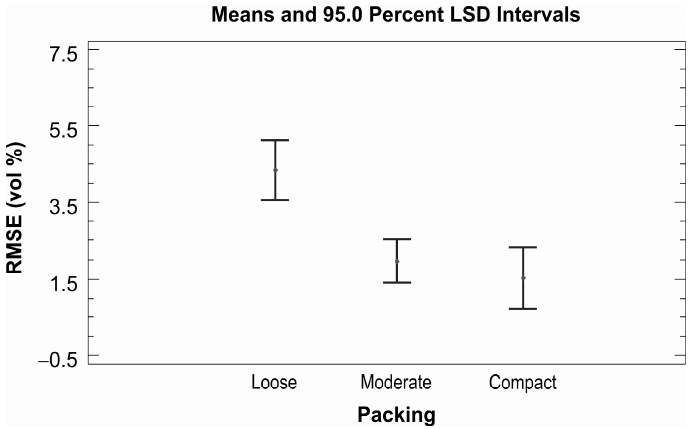
Figure 9. ThetaProbe—means and 95.0% LSD intervals of analysis of variance for RMSE and packing.